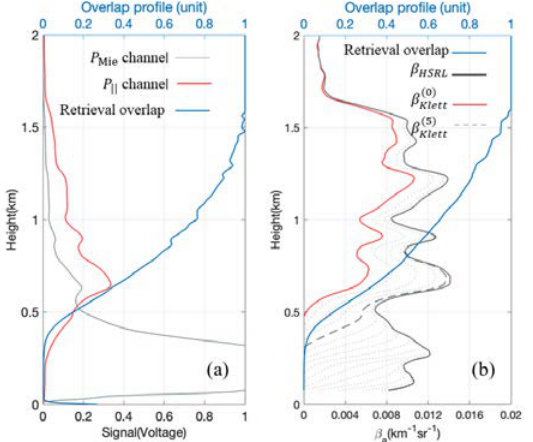
Fig.4 Overlap profile derived from dual field-of- view (a) and iterative method